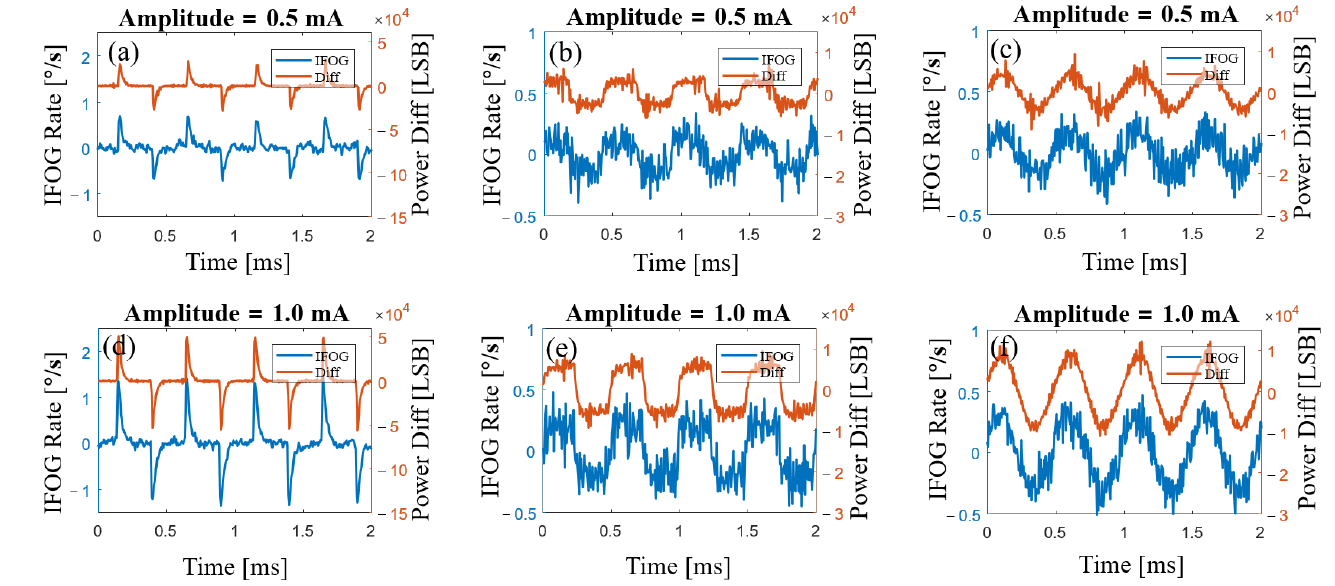
Figure 8. The differential signal of SLD power and original output signal of the gyroscope. The driving currents of the SLD in these experiments had the same bias of 100 mA. ( a , d ) Square-wave driving currents of the SLD with 0.5 mA and 1.0 mA amplitudes. ( b , e ) Triangle-wave driving currents of the SLD with 0.5 mA and 1.0 mA amplitudes. ( c , f ) Sine-wave driving currents of the SLD with 0.5 mA and 1.0 mA amplitudes.